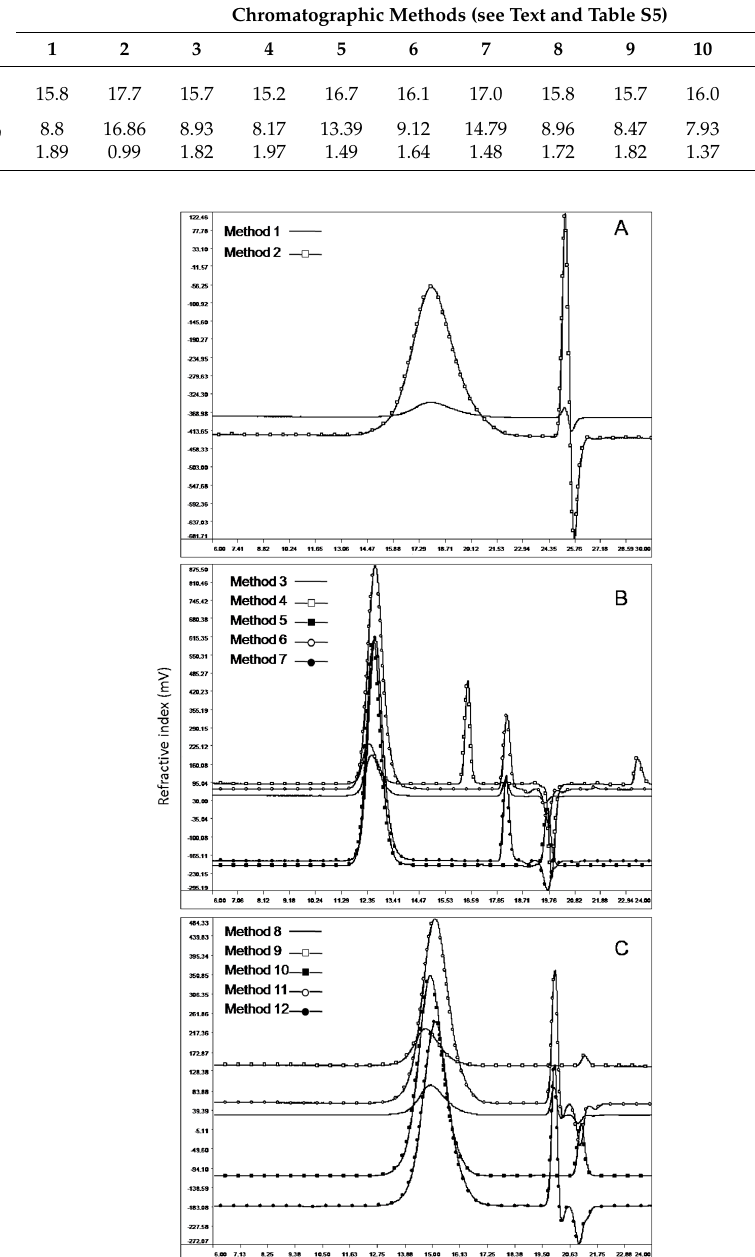
Table 1. Phase 2: Weight-average molecular weight ( M w , Da), percent proportion of material above 24,000 Da ( M 24,000 ) and the ratio M 8000–16,000 / M 16,000–24,000 (Ratio) of USP Heparin Sodium Identification RS, as measured using 12 distinct chromatographic methods. Results refer to the mean values of duplicate injections. Values were rounded to the nearest 100 Da.